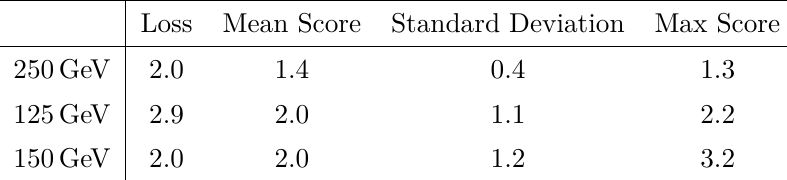
Table 2 . BCE Loss. Each entry corresponds to the injected cross section limit at which the plots from figure 4 and 5 cross the 2 σ band. The point of intersection is calculated as a linear interpolation between data points. These are taken from figure 5 unless the crossing occurs outside of that